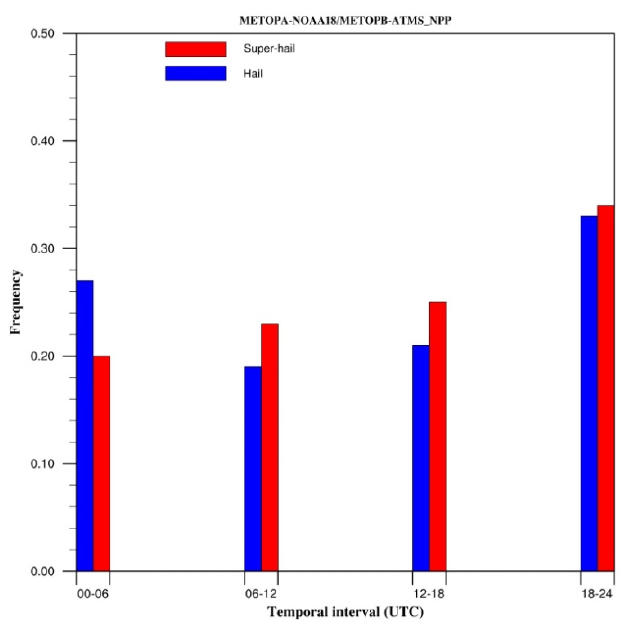
Figure 14. Relative frequencies of H (blue) and SH (red) events for the period 2013–2018 for the four-time intervals 00–06, 06–12, 12–18, and 18–00 UTC.